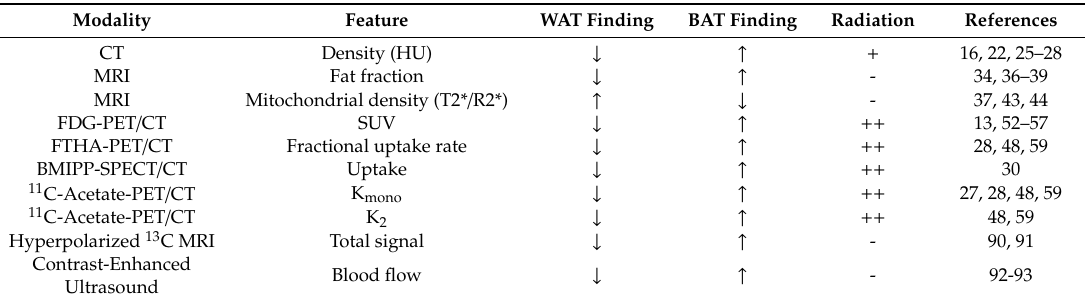
Figure 12. Physiological underpinnings of key imaging modalities for BAT research. The physiological basis for key imaging modalities in brown adipose tissue (BAT) research includes changes in inner action, vascularity, fat fraction, mitochondrial activity and key substrate transport and utilization. Comparison is made to white adipose tissue (WAT). N: nucleus, M: mitochondria, L: lipid droplet, FDG: 18 F-Fluorodeoxyglucose, FTHA: 18 F-Fluoro-6-Thia-Heptadecanoic Acid, BMIPP: 123 I-Beta-Methyl-Iodophenyl-Pentadecanoic Acid. Table 1. Major di ff erences between WAT and BAT on key imaging modalities. Comparison of WAT and BAT on key imaging modalities in BAT research. The relative finding of key factors are